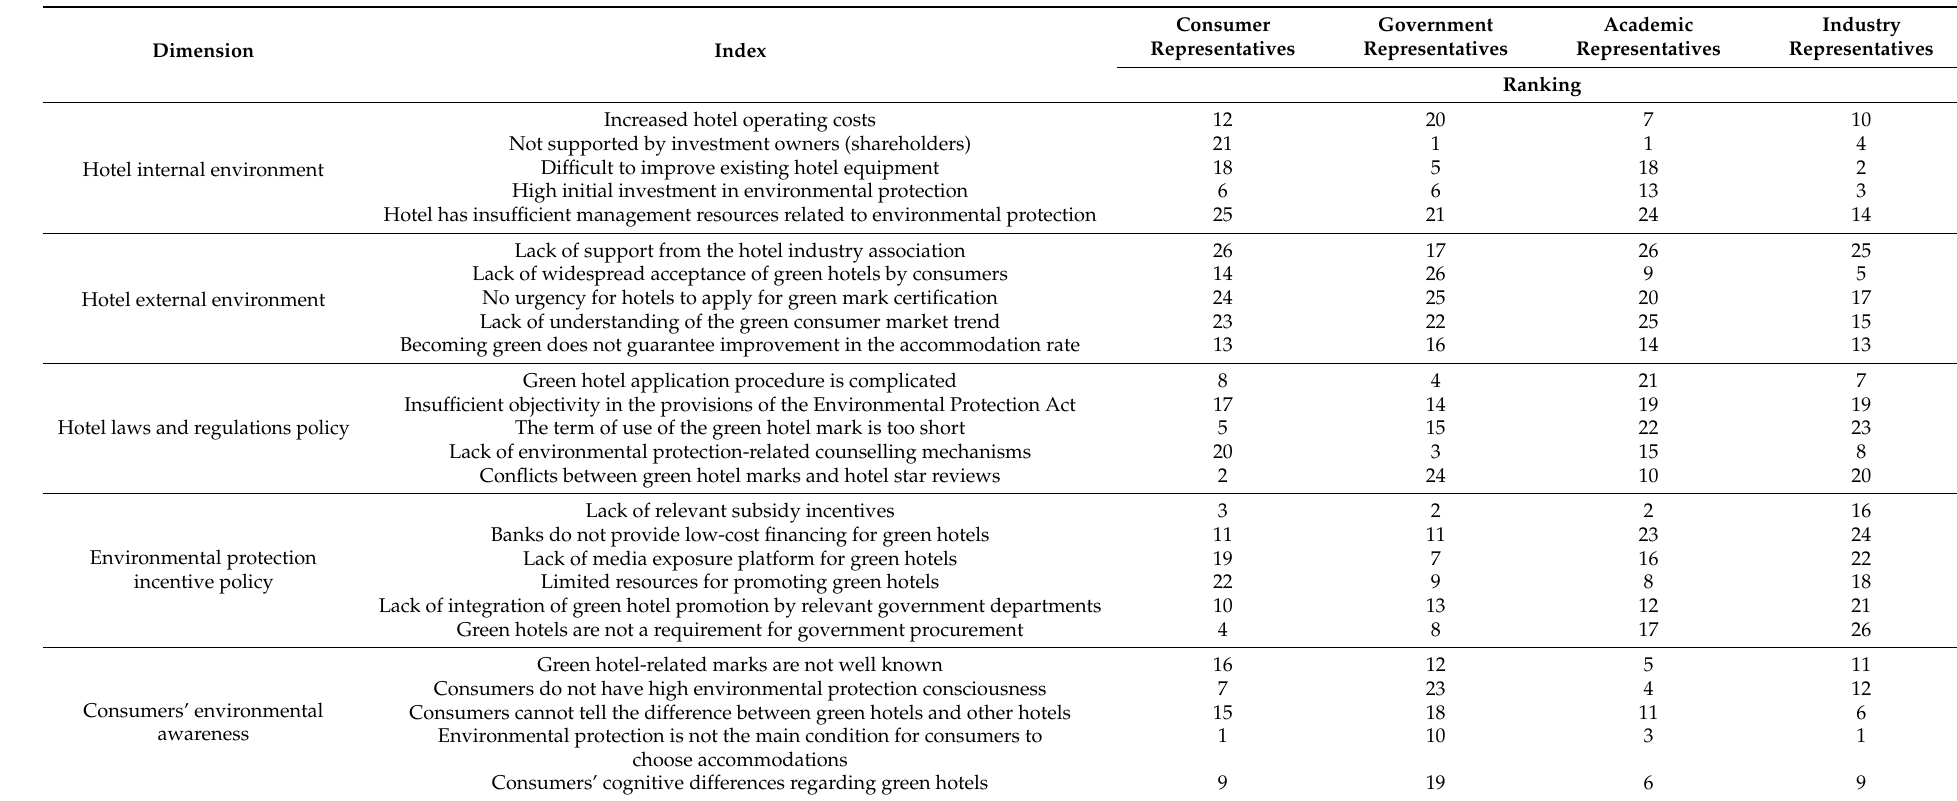
Table 4. Analysis of rankings of the relative weights of indices that hindered green hotel certification, as indicated by all scholars and